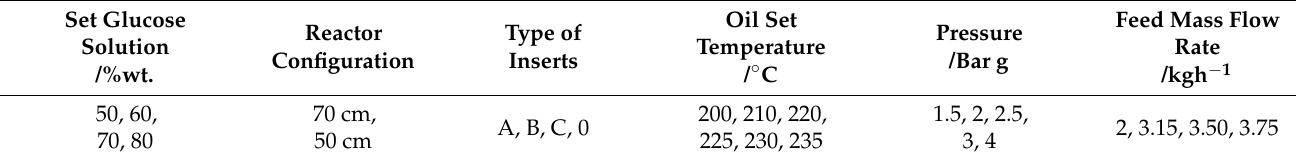
Table 3. Operating conditions set during the